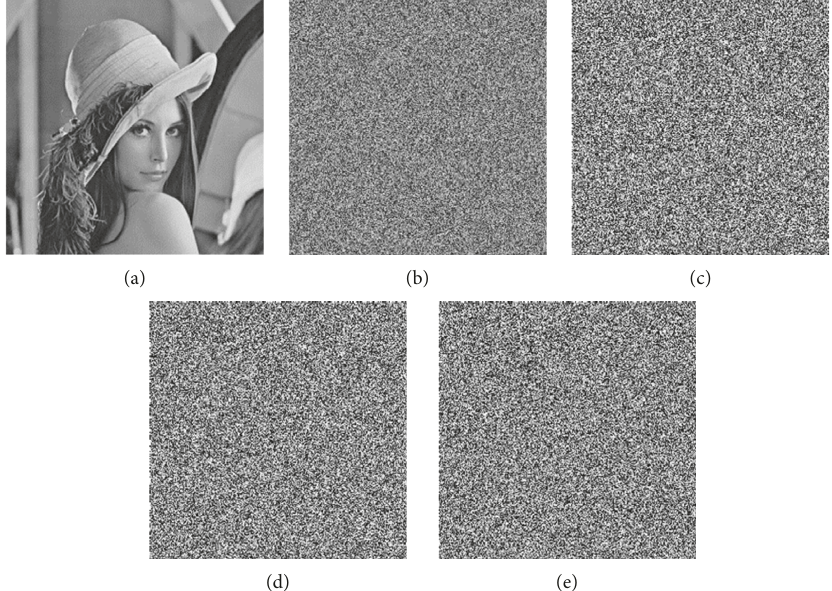
Figure 7: Decrypted images with the keys have minimal change. (a) Correct decrypted image. Decrypted image (b) when a (1) changed 10 − 15 , (c) when x (1) changed 10 − 15 , (d) when y (1) changed 10 − 15 , and (e) when θ changed 10 − 15